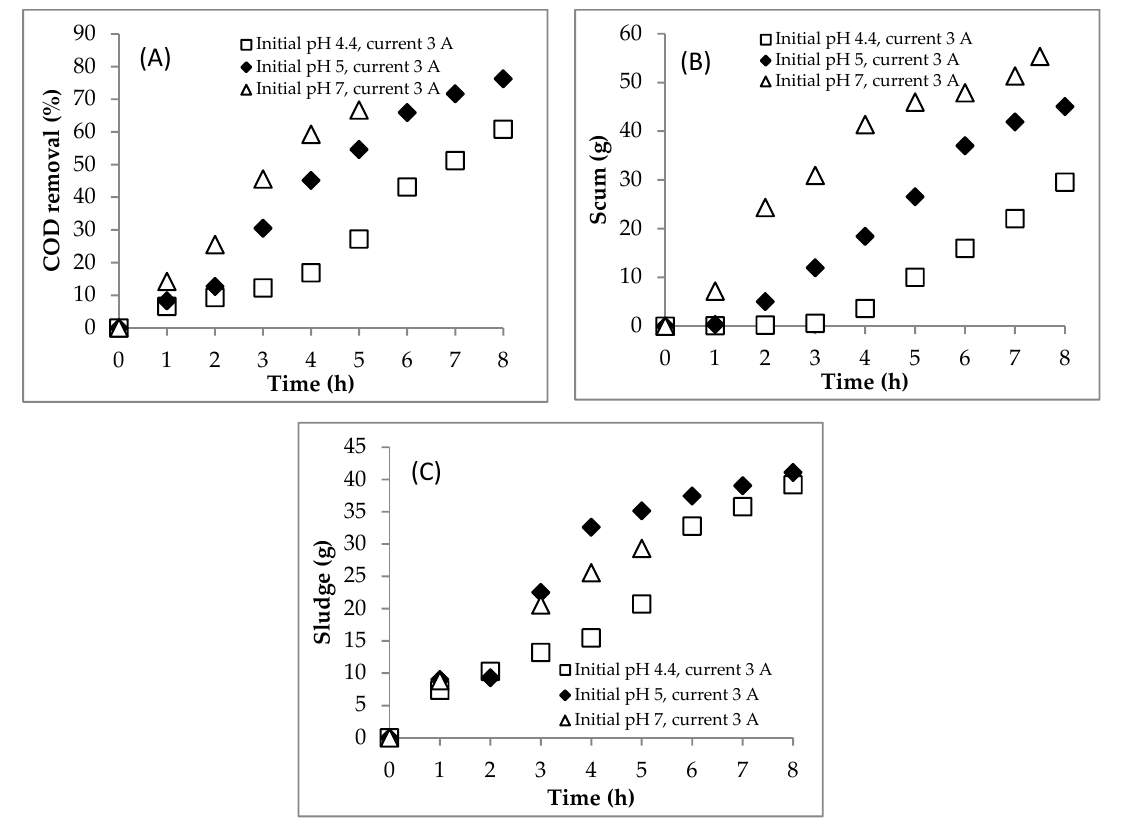
Figure 5. Effect of the initial pH on ( A ) COD removal, ( B ) scum production and ( C ) sludge production during the EC process. Initial COD of 112,948.5 mgL − 1 ; constant current of 3 A; initial temperature of 26 – 30 °C.